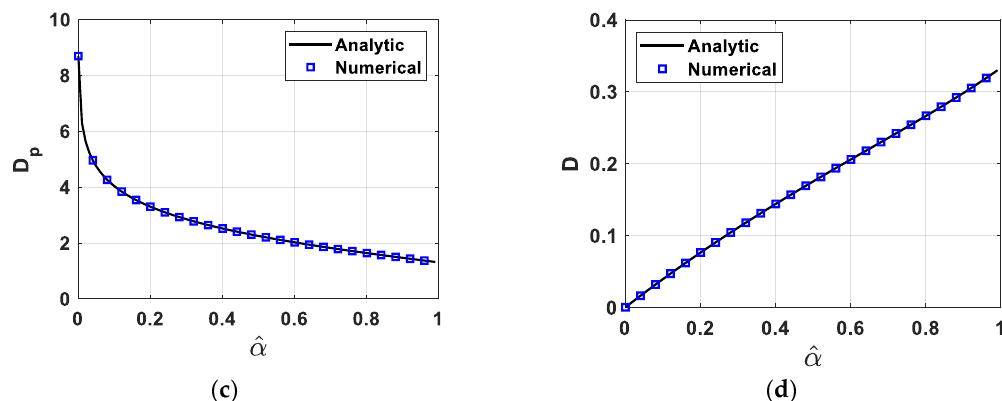
Figure 1. Analytical solutions from Equation (22) (Section 3.1) and numerical solutions from Equation (23) are shown for biexponential model parameters ( a ) f p , ( b ) 1 − f p , ( c ) D 0 , and ( d ) D, as functions of the stretched exponent ˆ α , both for b = 0, 1, 2, 3 and D se = 1/3.